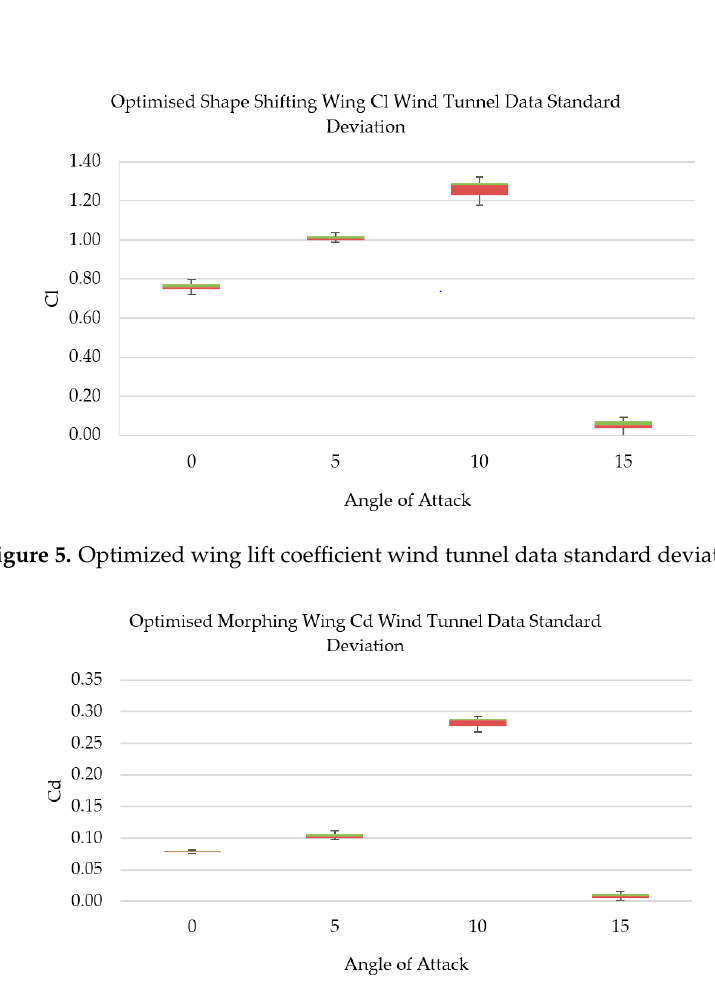
Figure 6. Optimized wing drag coefficient wind tunnel data standard deviation.